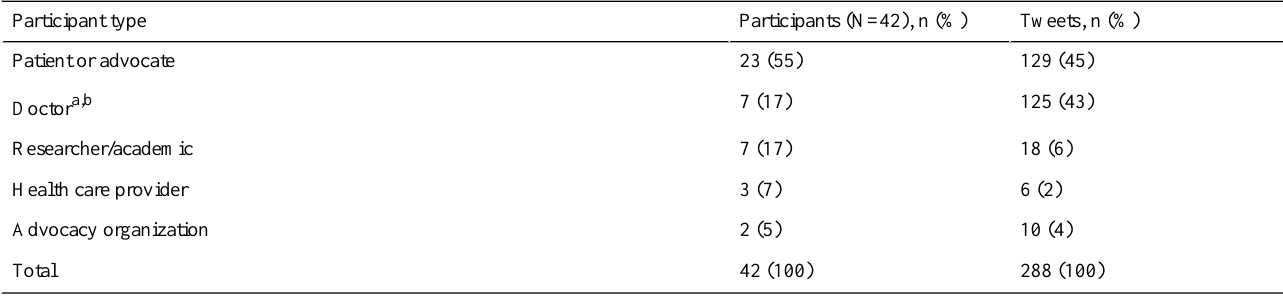
Table 1. Description of #BCSM community Twitter chat